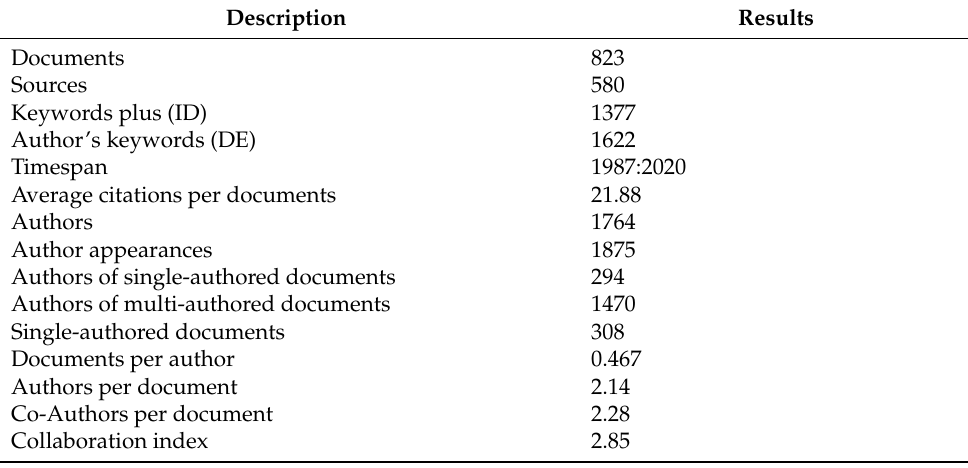
Table 1. Descriptive characteristics of the literature on the “glass